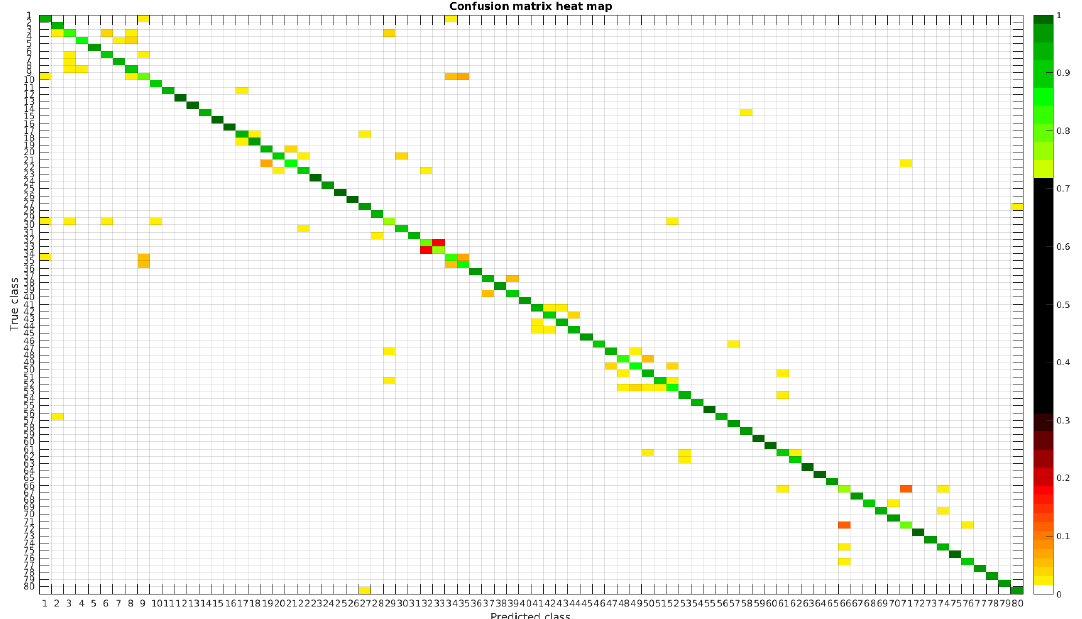
Figure 18. Confusion matrix heat map for the merged dataset with 300 samples per